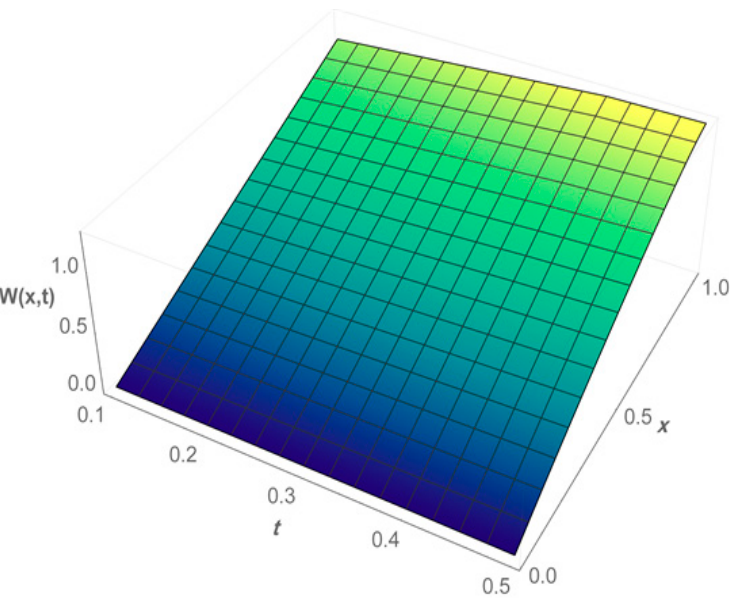
Figure 2. Graphs of the approximate solutions 𝑊(𝑥 , 𝑡) for 𝑡 ≤ 0.5 (ℎ = 0.0125, 𝑘 = 0.0005) .